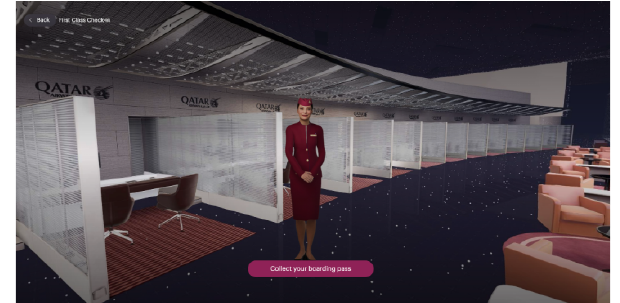
Figure 30: QVERSE: Qatar Airways Lounge in the metaverse